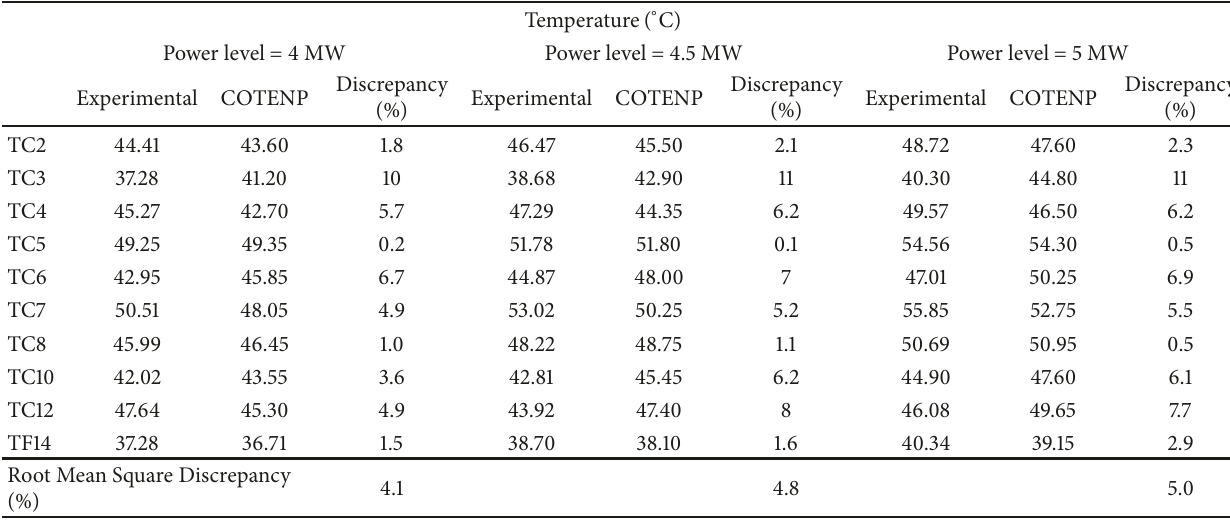
Table 2: Temperature results obtained with the COTENP code for the IEA-R1 reactor at different power levels. Temperature results simulate measurement results at different locations of the IFA. The IFA is located at the (6,8) position. Inferred error from experimental results is + 0.25 ∘ C or + 0.5 %.